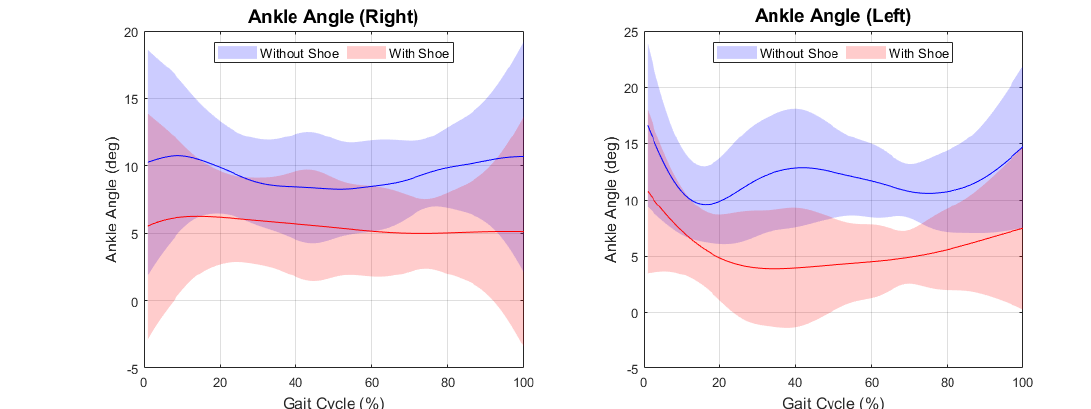
Figure 6. Maximum knee joint angles of flatfoot subjects with and without shoes. r-right; l-left.